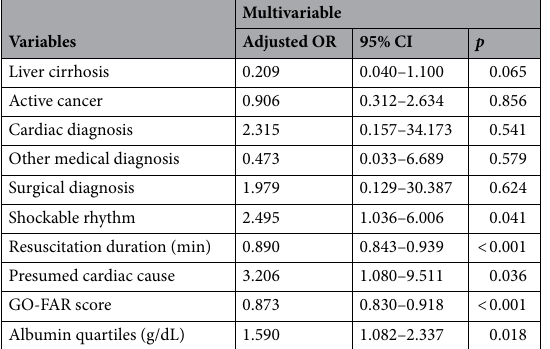
Table 2. Multivariable logistic analysis for favorable neurologic outcome on discharge in the derivation cohort. OR odds ratio, CI confidence interval, GO-FAR score Good Outcome Following Attempted Resuscitation score.